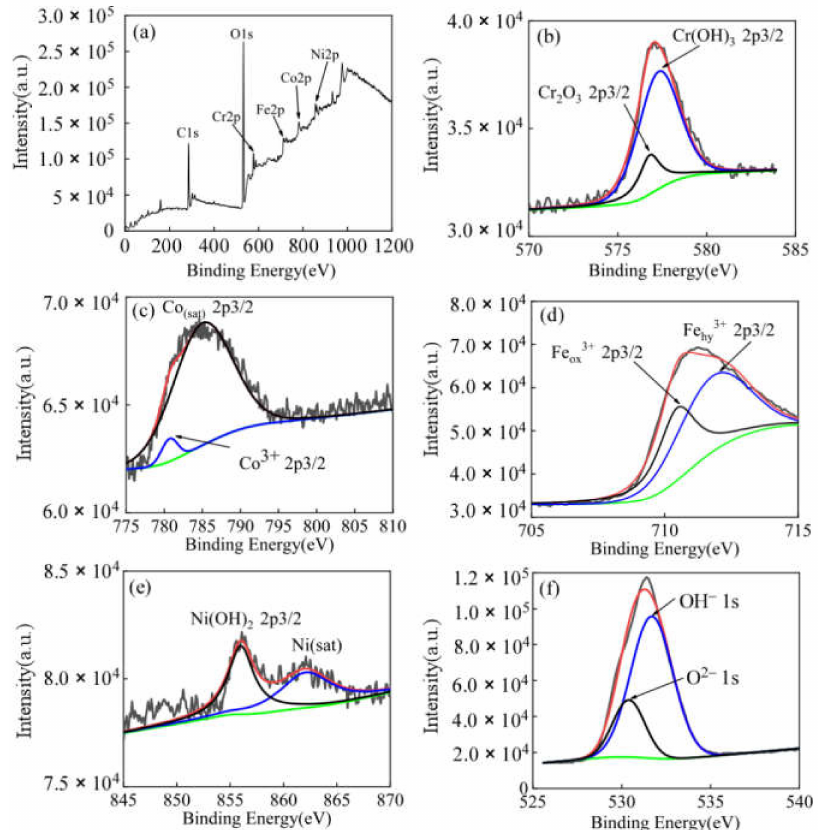
Figure 9. High-resolution XPS pattern of the passivation film on FeCoNiCrBSiNb coating in 3.5 wt.%NaCl solution. ( a ) suevey spectrum; ( b ) Cr 2p3/2; ( c ) Co 2p3/2; ( d ) Fe 2p3/2; ( e ) Ni 2p3/2; ( f ) O 1s detail